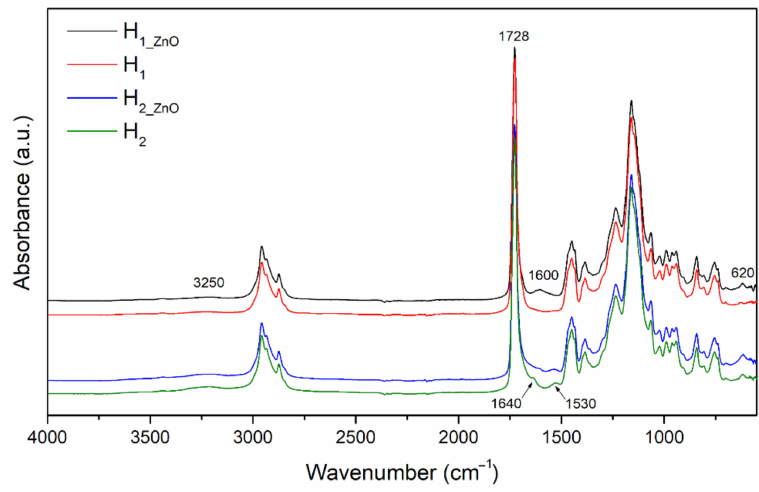
Figure 2. FT-IR spectra of H-labelled latex coatings of Series 1 and Series